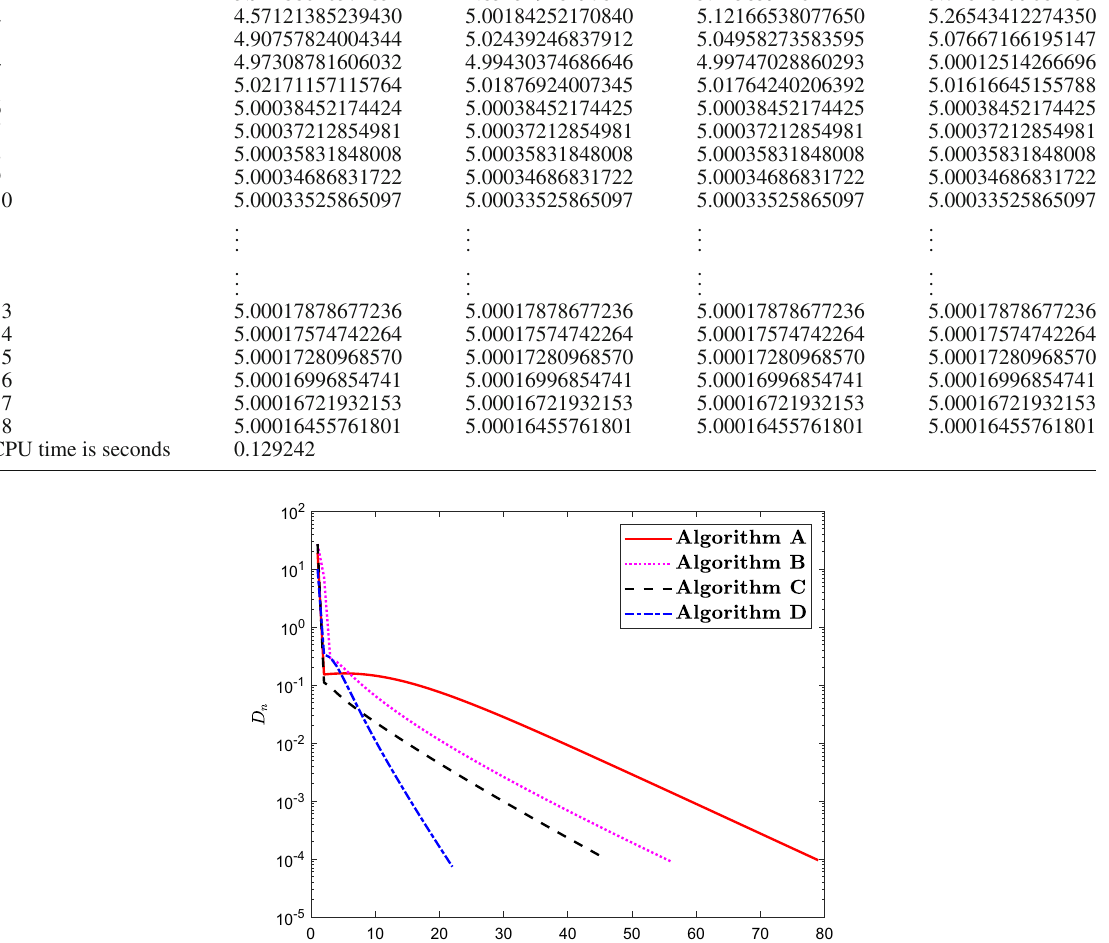
Iter ( n ) u 1 u 2 u 3 u 4 1